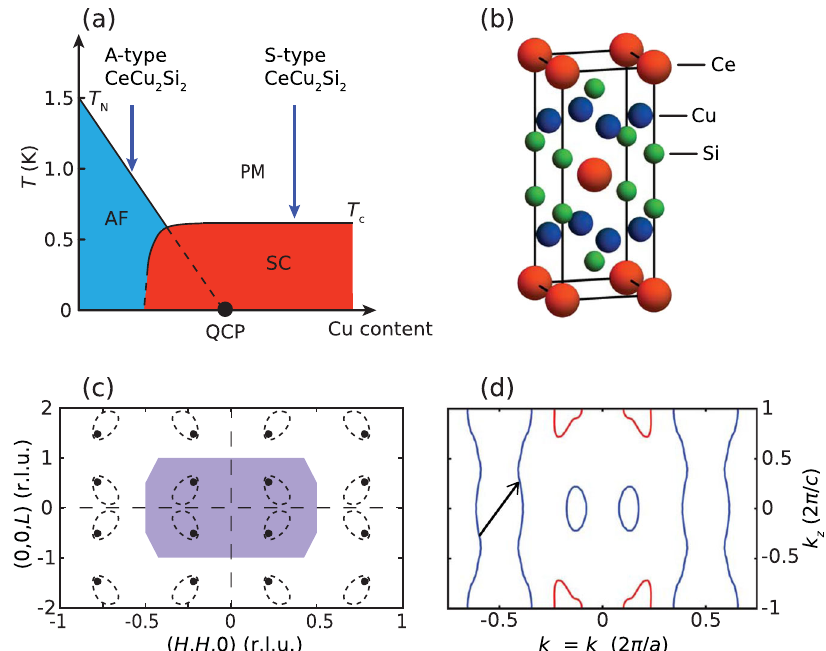
Fig. 1 Crystal structure, phase diagram, and reciprocal space of CeCu 2 Si 2 . a Schematic phase diagram of CeCu 2 Si 2 . b Crystal structure of CeCu 2 Si 2 , with Ce 3 + ions forming a body-centered tetragonal lattice. c [ H , H , L ] scattering plane of CeCu 2 Si 2 , with the shaded area representing a Brillouin zone for the Ce 3 + ions. The black dots indicate magnetic Bragg peaks in A-type CeCu 2 Si 236 , and the dashed ovals are schematic intensity contours of low-energy AF excitations in our S-type CeCu 2 Si 2 . d Slice of the CeCu 2 Si 2 Fermi surface with k x = k y , and the arrow represents the intraband nesting vector. The electronic structure used in this work is identical to that in ref. 46 , and 3D plots of the Fermi surfaces are shown in Supplementary Fig.